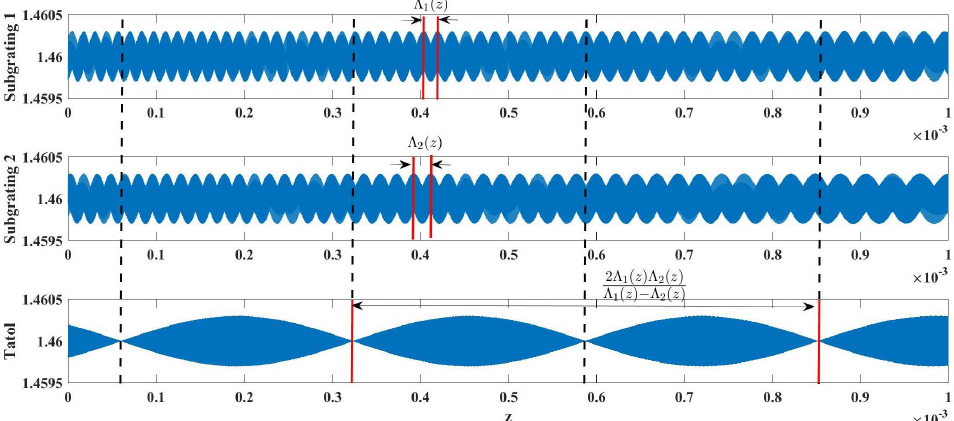
Figure 2. Schematic diagram of the refractive index modulation of a 2D chirped fiber